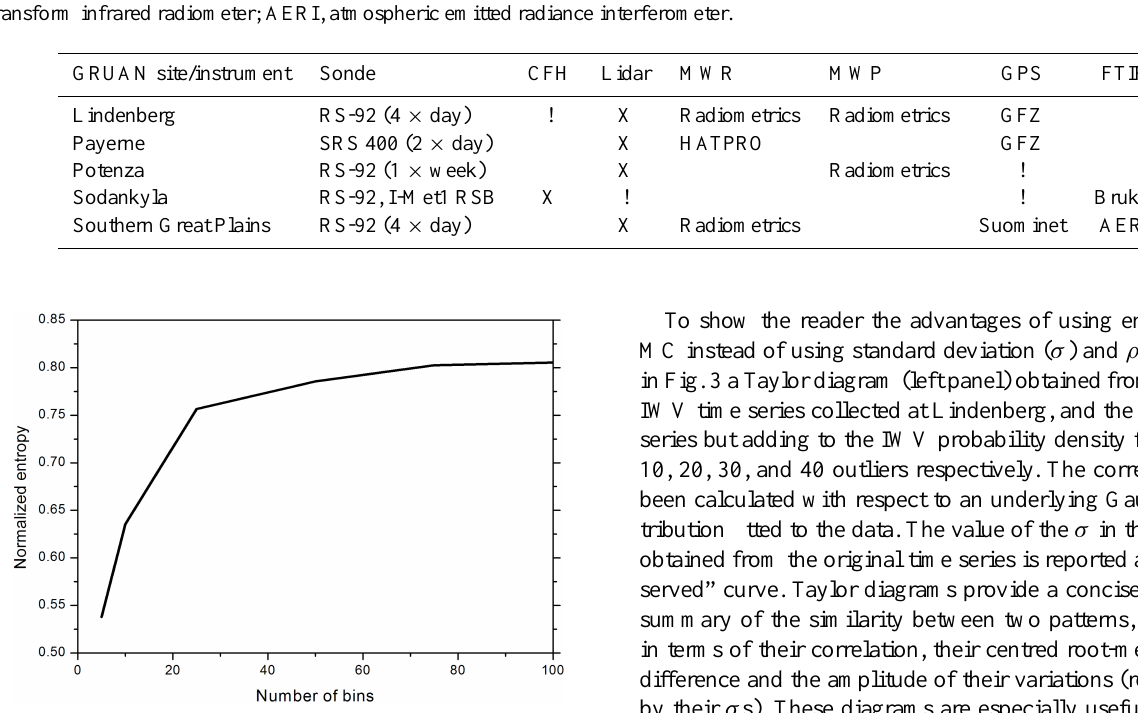
Table 1. Instruments available (and model when applicable) at the GRUAN sites generating data sets considered in this study of uncertainty and redundancy. Symbol ! indicates that the instrument is available at the site, but the data were not used in the study. Abbreviations: CFH, cryogenic frost-point hygrometer; MWR, microwave radiometer; MWP, microwave profiler; GPS, global positioning system; FTIR, Fourier transform infrared radiometer; AERI, atmospheric emitted radiance interferometer.